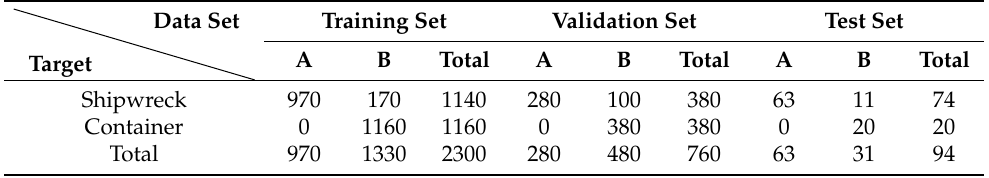
Table 2. The division of the training set, validation set and test set after data